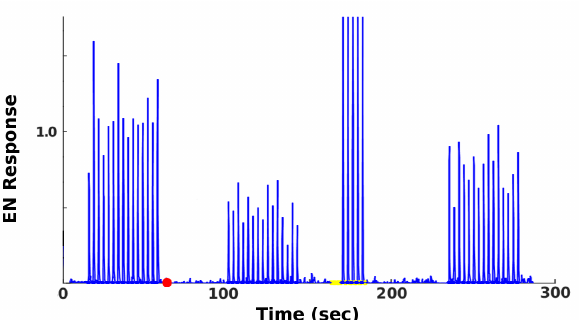
Figure 3. Typical EN timecourse. Readouts from the EN in a typical experiment, in which injury attenuated the EN odor response, and training partly restored it. x -axis is time. y -axis gives magnitude of EN response (dimensionless units), with pre-injury response to the odor ≈ 1 (absent odor, EN response ≈ 0). Events (with times in parentheses) are: Naive response (20–55); injury (red dot at 60); injured response (100–150); 5 puffs training (170–190), with the very strong (cropped) responses due to octopamine; post-training response